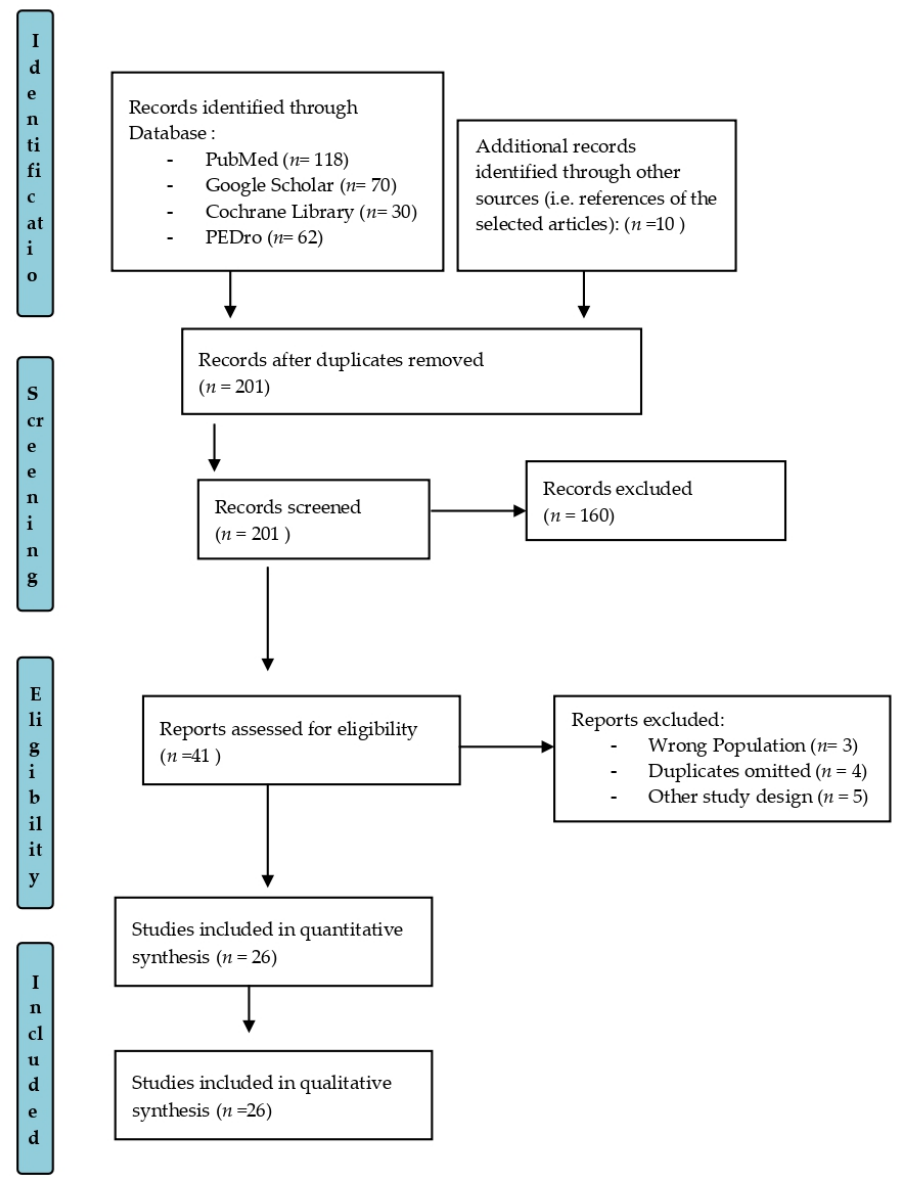
Figure 1. PRISMA flow diagram for study selection.